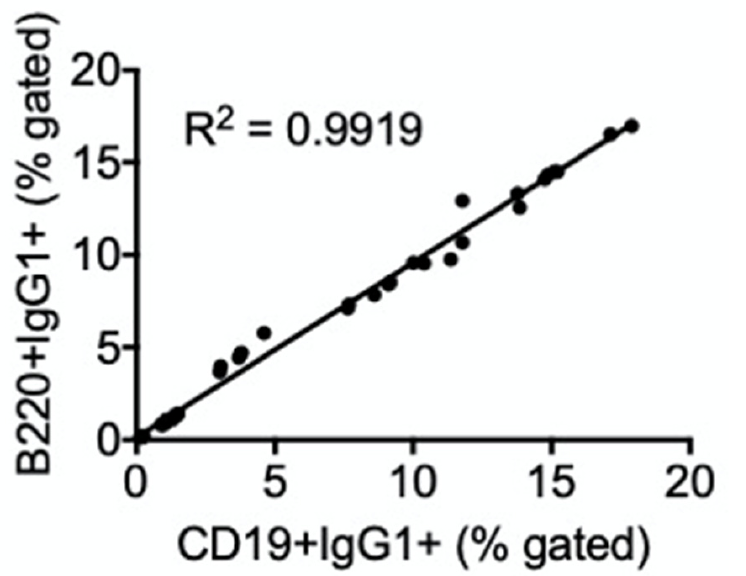
Figure 6. Percent of CD19+IgG1+ and B220+IgG1+ cells were correlated. Percent CD19+IgG1+ and B220+IgG1+, regardless of treatment, were plotted. Data were obtained from one of the representative in vitro experiments in which IgG1 was evaluated on CD19+ and B220+ cells. The positive correlation regression line is significant at p < 0.0001.